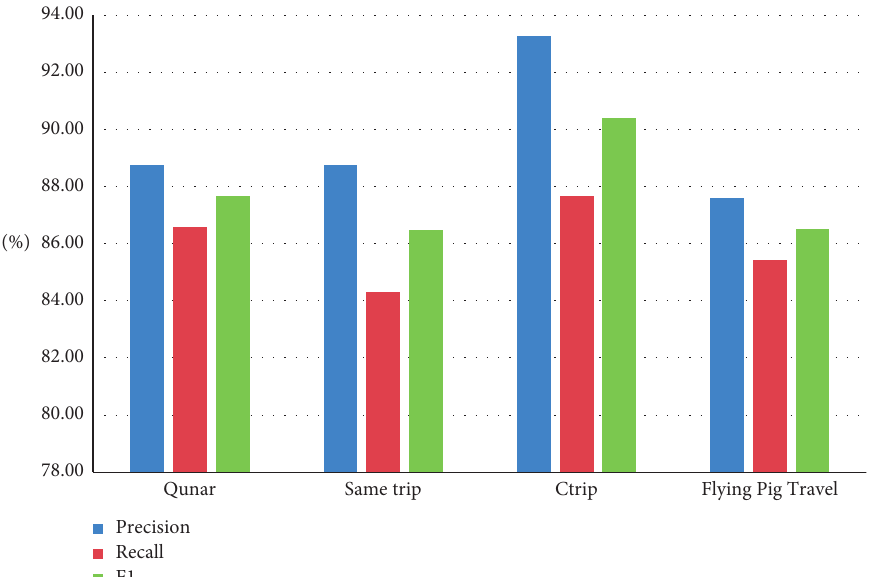
Figure 14: Comparison of travel booking recommendation performance of travel platform.